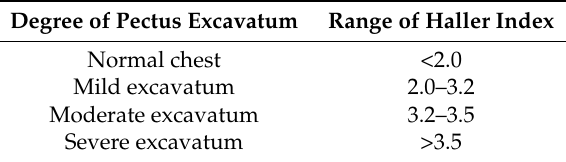
Table 1. Classification of the Haller index.